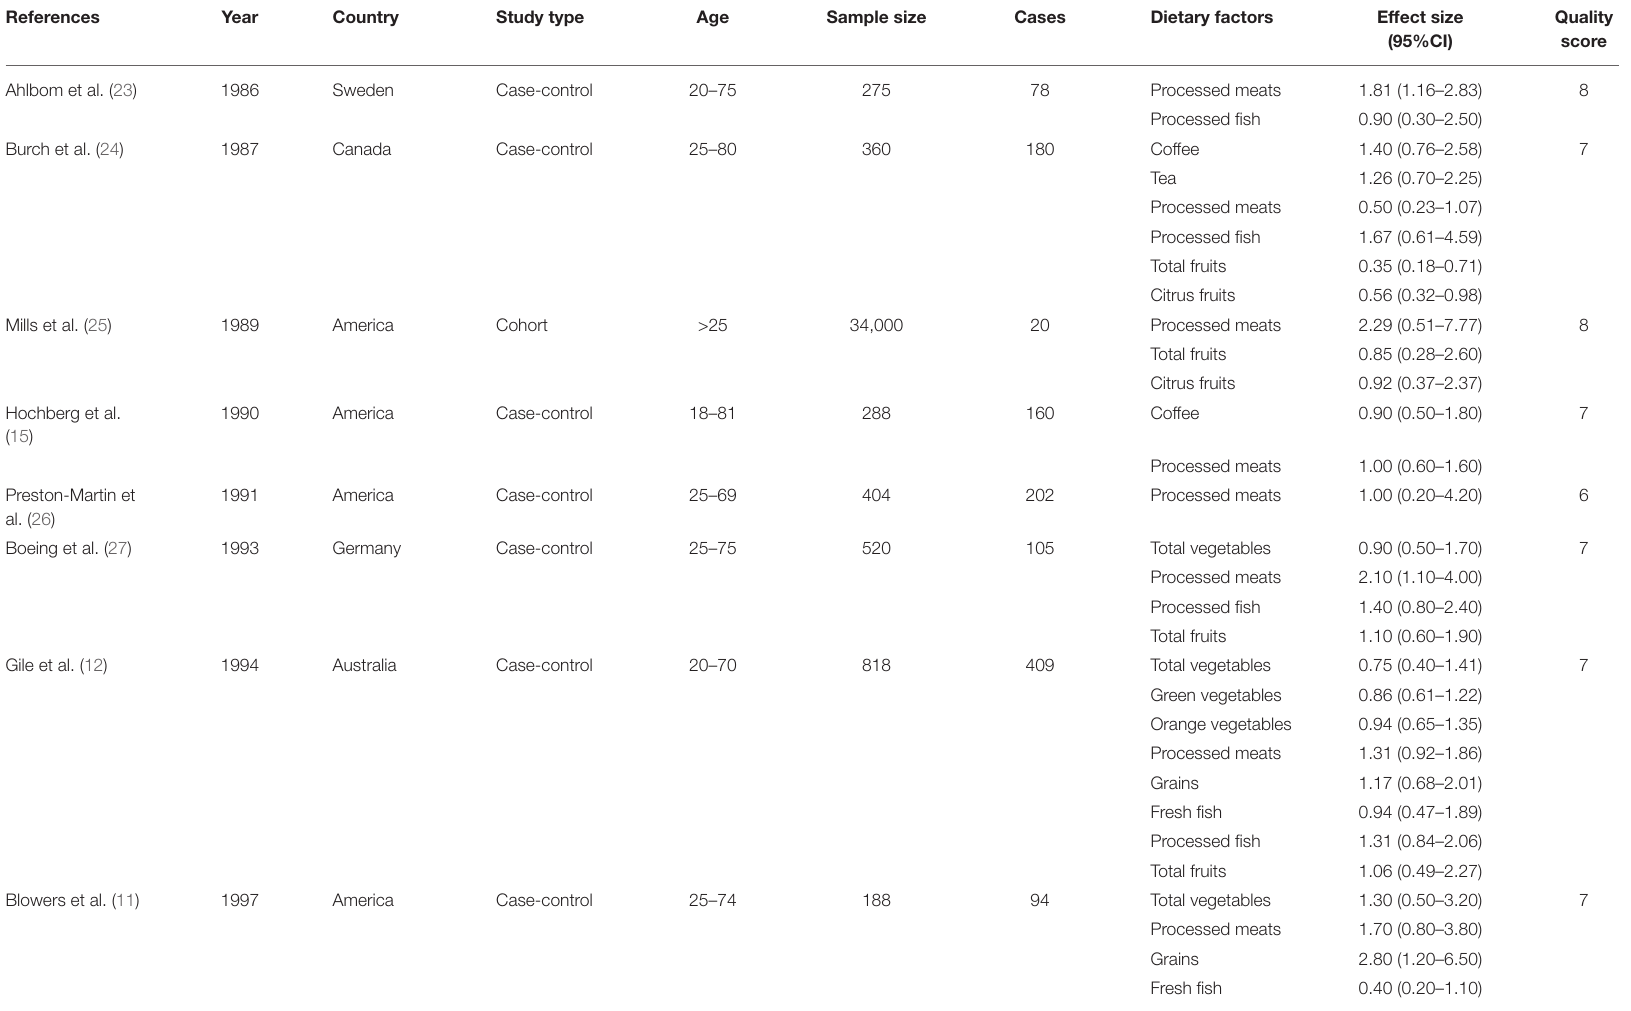
TABLE 1 | Characteristics of studies investigating the association between dietary factors and